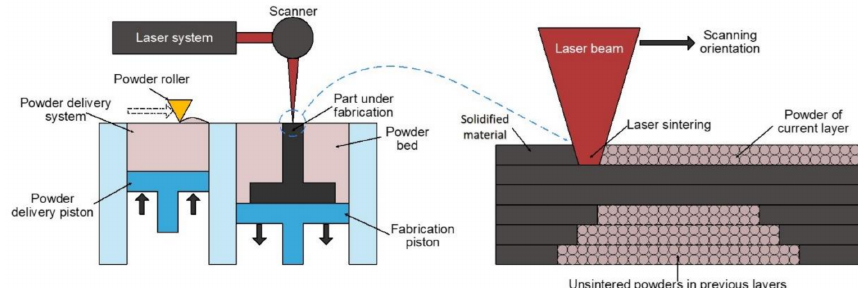
Figure 1. The schematic illustration of the selective laser melting (SLM)